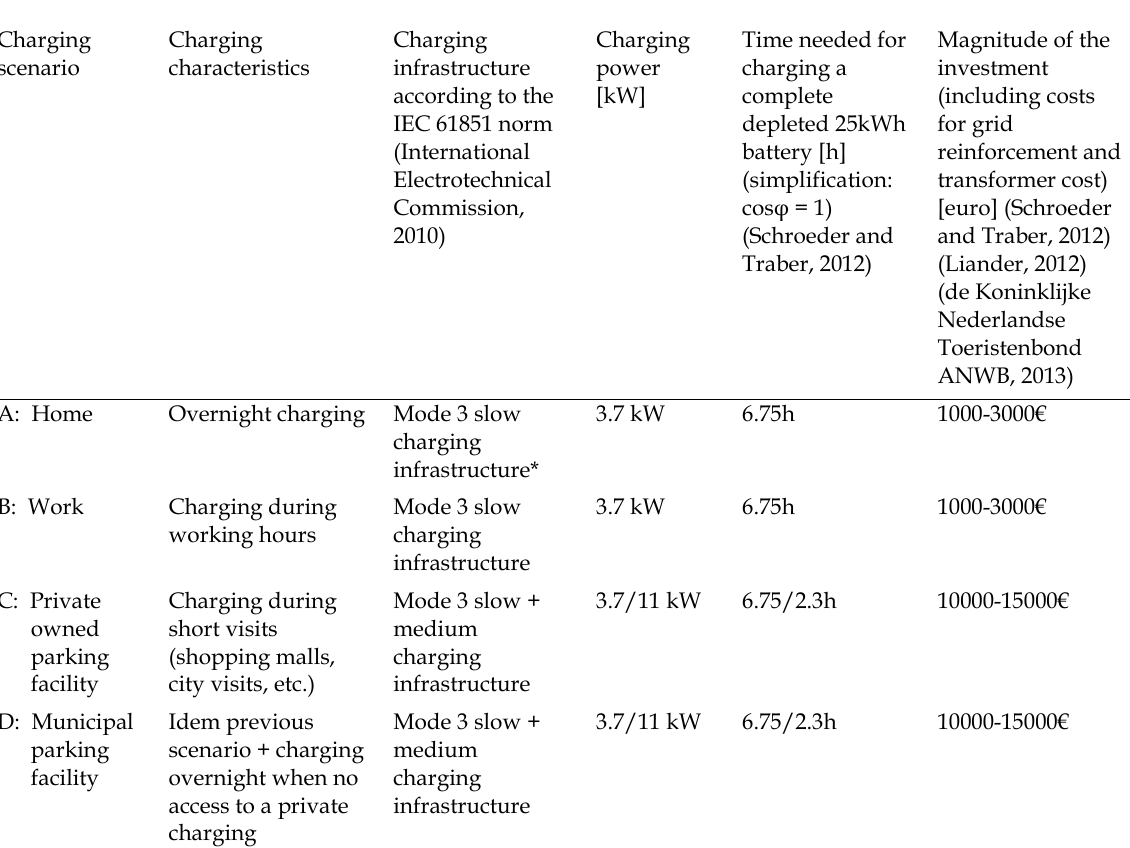
Overview of EV charging